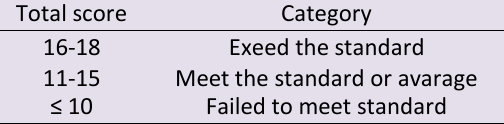
Table 1 . Oral Communication Assessment Criteria